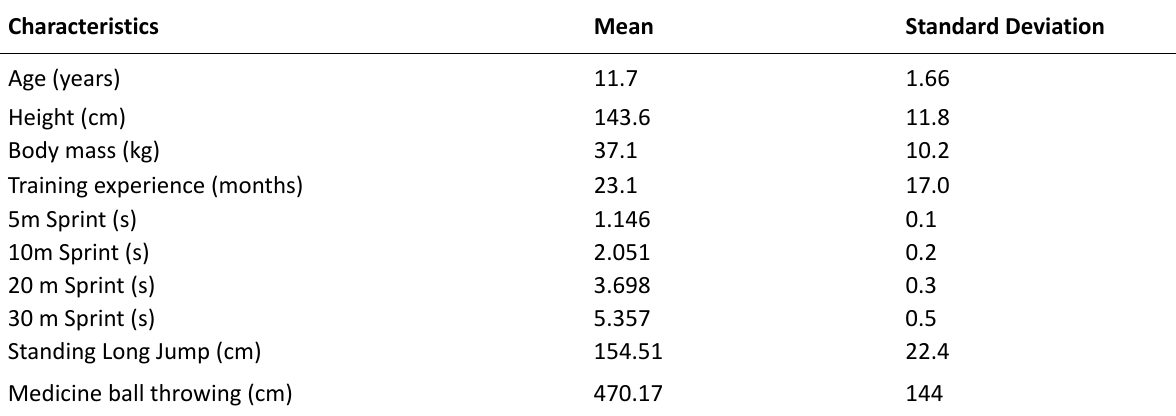
Table 1. The soccer players’ physical characteristics and test performances (n=147) Characteristics